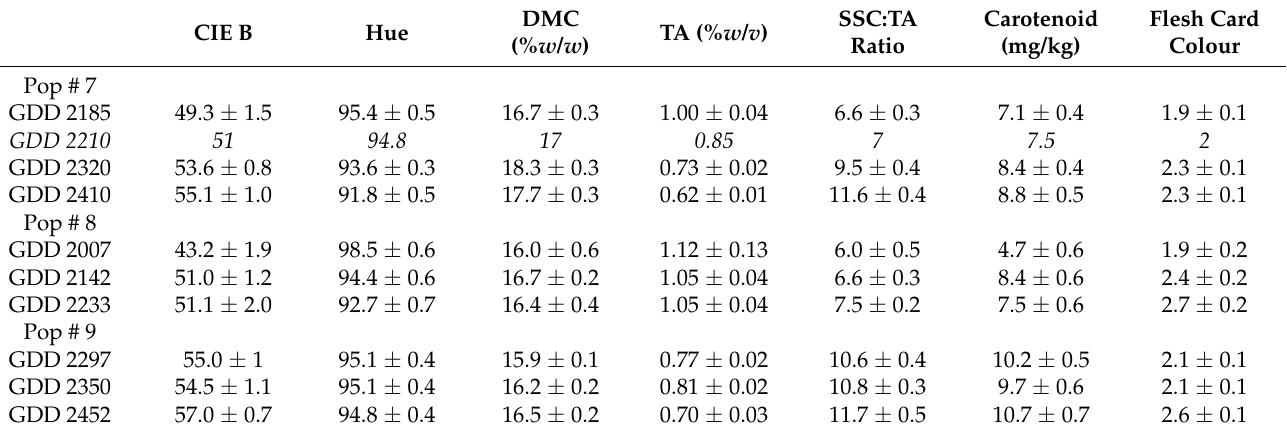
Table 8. Observed values of Keitt fruit attributes at two or three harvest dates with CIE B value bracketing the target value of 51, and values at the target value, in italics, as estimated by interpolation. GDD are calculated from asparagus stage with Tb = 12 ◦ C, and TB = 32 ◦ C for fruit of three populations. Panicles were tagged on one date and harvested on a range of dates. Population numbers refer